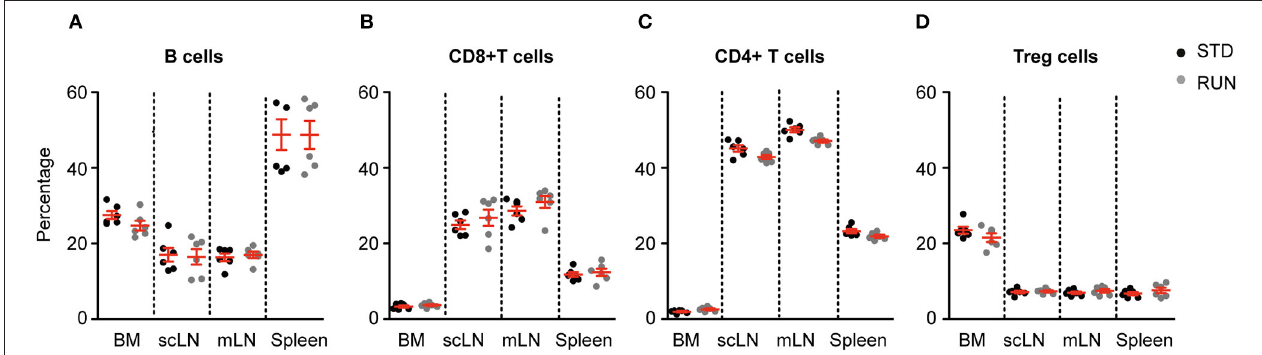
FIGURE 4 | Running does not influence lymphocyte distribution in the bone marrow or peripheral lymphoid organs . Physical exercise did not change the distribution of B cells (A) , CD8 + T cells (B) , CD4 + T cells (C) or Tregs (D) in the bone marrow, lymph nodes or spleen. Mesenteric lymph nodes (mLN), subcutaneous lymph nodes (scLN). Symbols and horizontal lines indicate individual mice and mean values ± SD, respectively. Data were analyzed using a two-tailed Mann Whitney